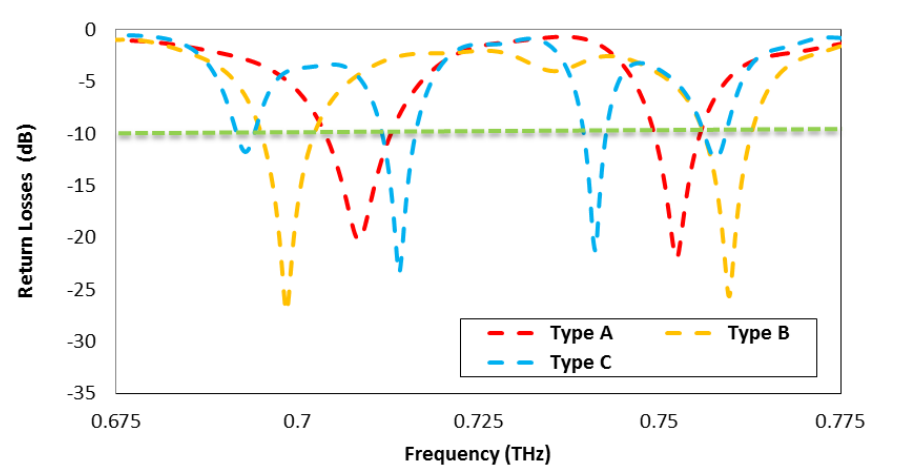
Figure 8. Comparison of return loss vs.